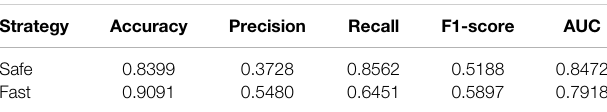
TABLE 9 | Classi fi cation performance metrics for the safe and fast